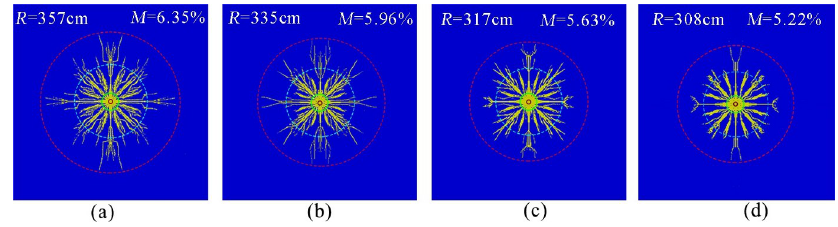
Fig 5. Crack distribution under different ground stresses. (a) In situ stress 15 MPa.(b) In situ stress 18 MPa.(c) In situ stress 21 MPa.(d) In situ stress 24 MPa.